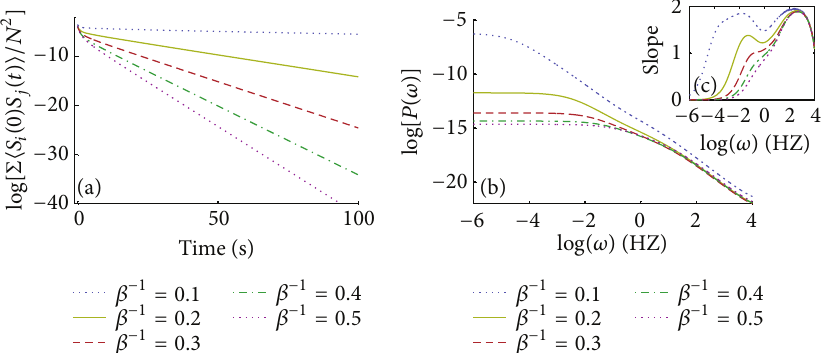
Figure 3: Temperature dependent (a) correlation functions, (b) power spectrum, and (c) slopes of the power spectrum for 𝑁 = 10 spins.